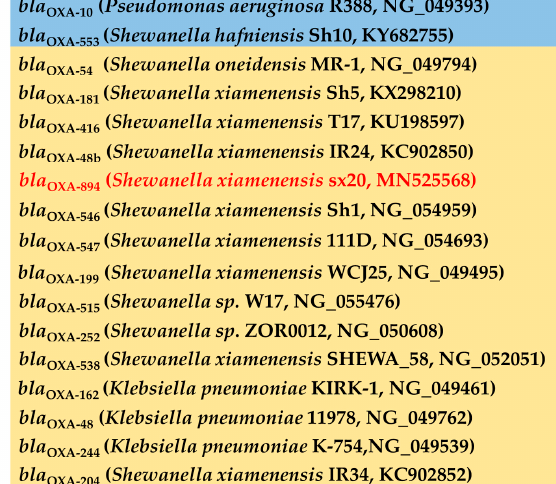
Figure 2. Molecular phylogenetic analysis using maximum likelihood method with 1000 bootstraps of bla OXA-894 with closest matches and representative nucleotide sequences retrieved from the GenBank database. The phylogenetic tree was constructed using MEGA X software. Bootstrap confidence is shown in %. The bla OXA-48 -like genes are shown in yellow boxes, and other genes are highlighted in blue boxes.